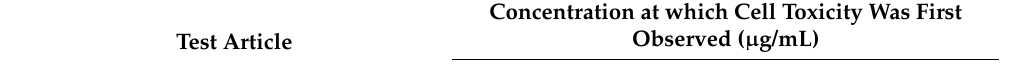
Table 2. Results of test article cell